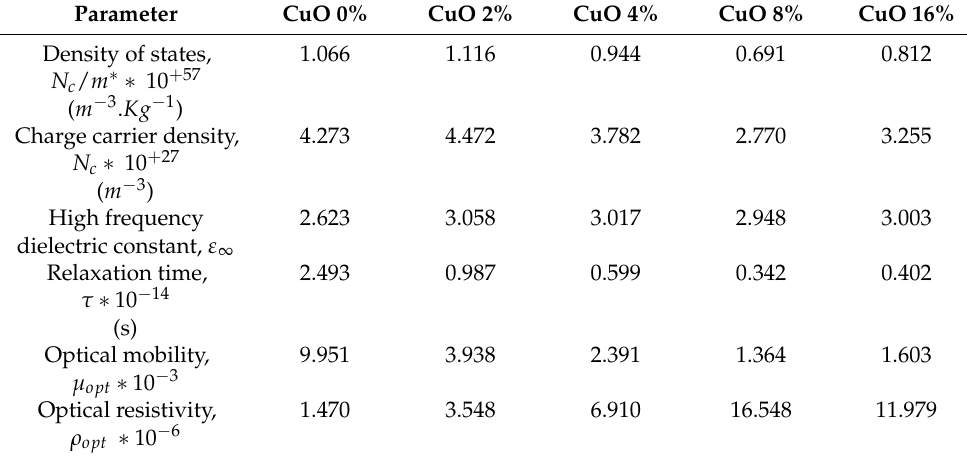
Table 2. The estimation of key essential optoelectronic parameters of PMMA–PVA/CuO nanocom- posite thin films for various CuO NPs concentrations.